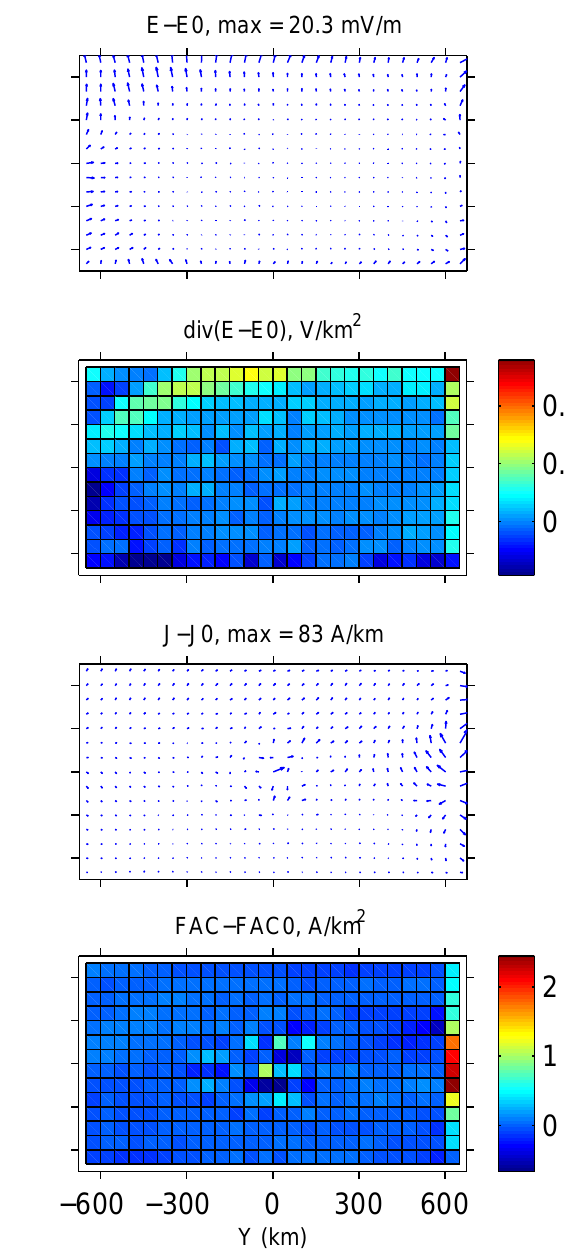
CECS basis functions are not optimal for representing es- sentially 1-dimensional structures, as discussed in Sect.